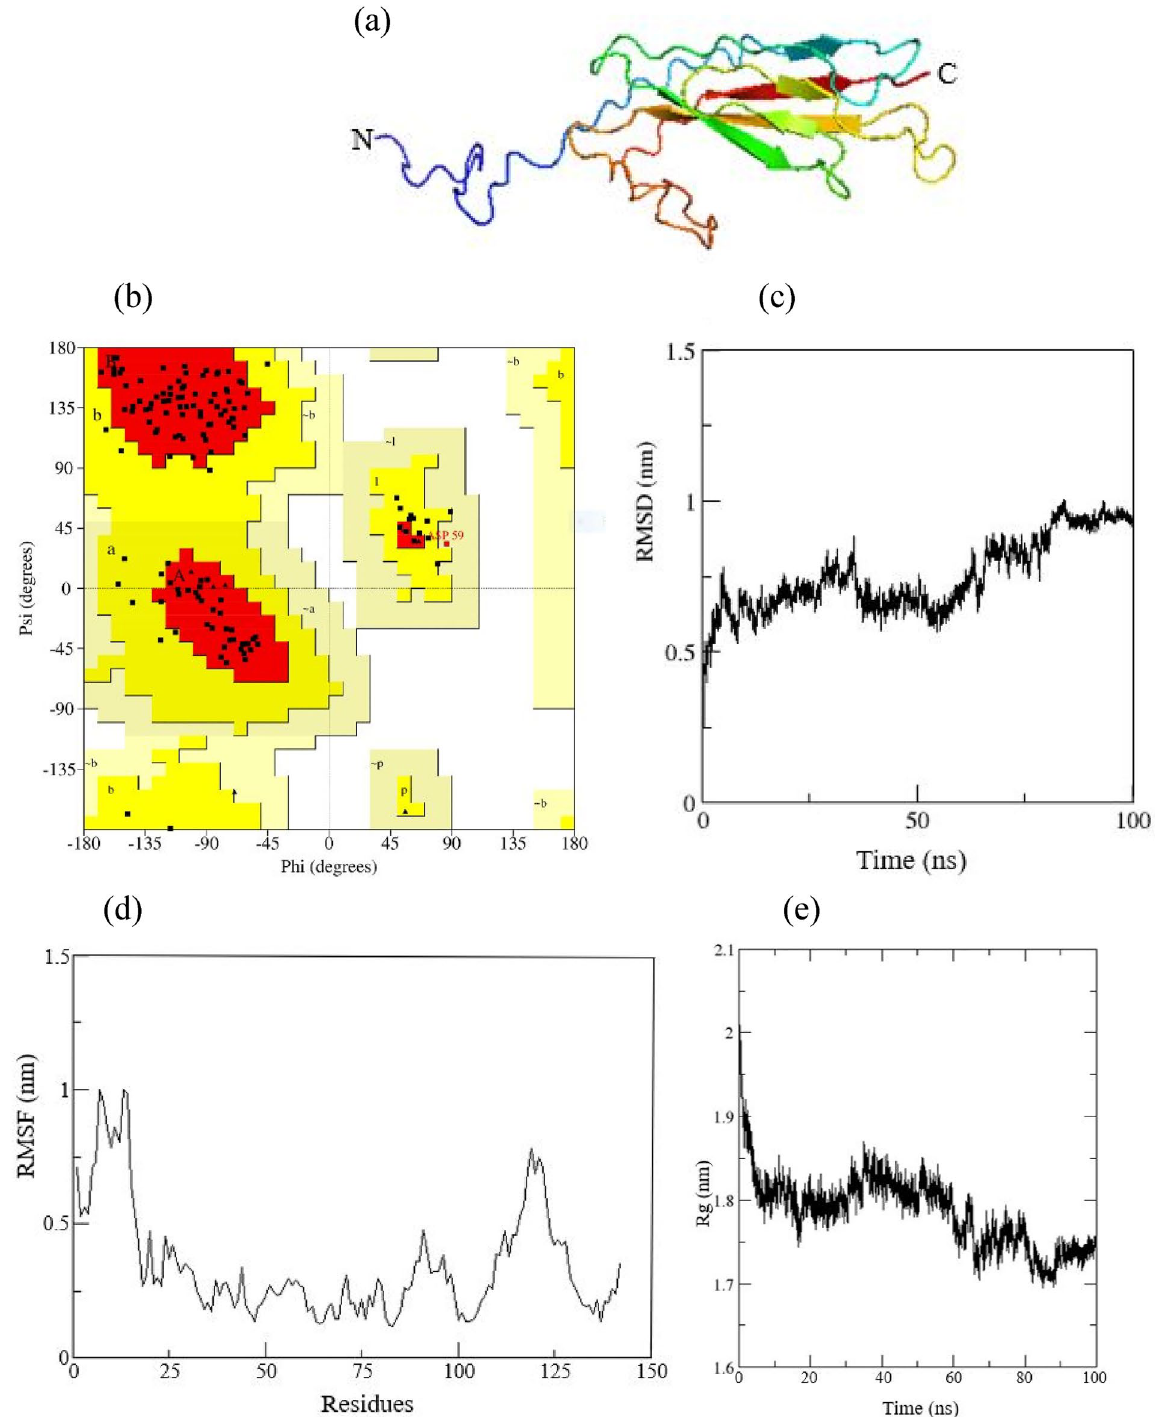
Figure 5. Structural representation and stability parameters of ss asprosin after stimulation. ( a ) 3D model of ss asprosin in which arrow represent the β-sheets. ( b ) Ramachandran plot of amino acid residues of ss asprosin. ( c ) RMSD (Root mean square deviation) of the backbone C ɑ atoms of ss asprosin vs time. ( d ) RMSF (Root mean square fluctuation) of each residue of ss asprosin vs time. ( e ) Rg (Radius of gyration) vs